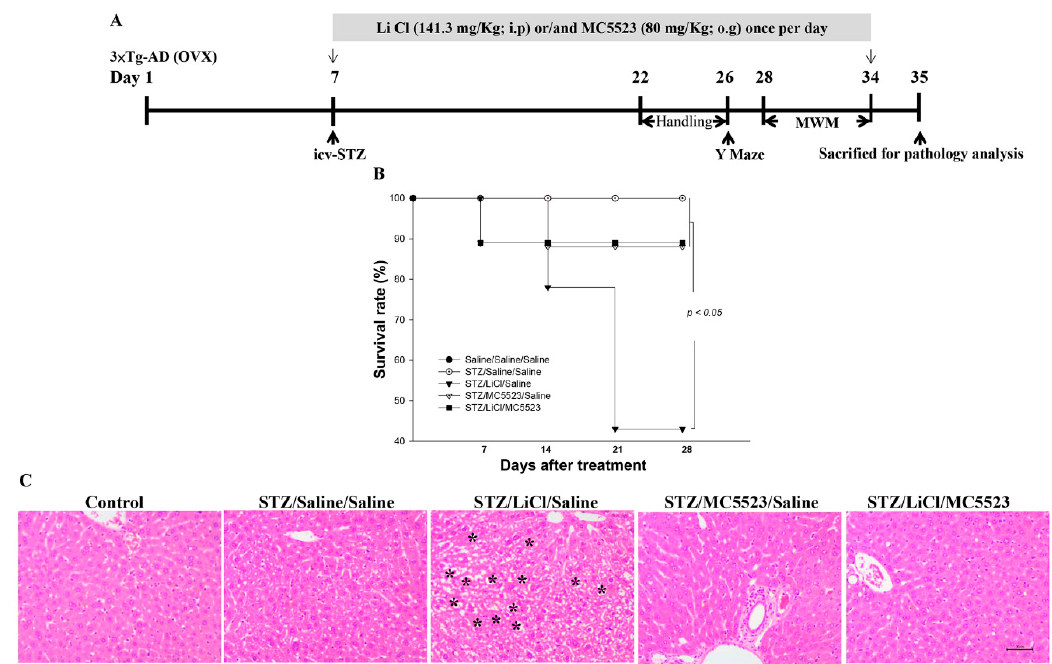
Figure 1. MC5523 increased the survival rate and reduced hepatotoxicity in LiCl-treated icv-STZ OVX 3×Tg-AD mice. (A) The timeline of the treatment with LiCl, MC5523, and LiCl plus MC5523 in the icv-STZ OVX 3×Tg-AD mice. (B) Kaplan-Meier graph showing the survival pattern in each group of icv-STZ OVX 3×Tg-AD mice treated with LiCl, MC5523, and LiCl plus MC5523. (C) The results of